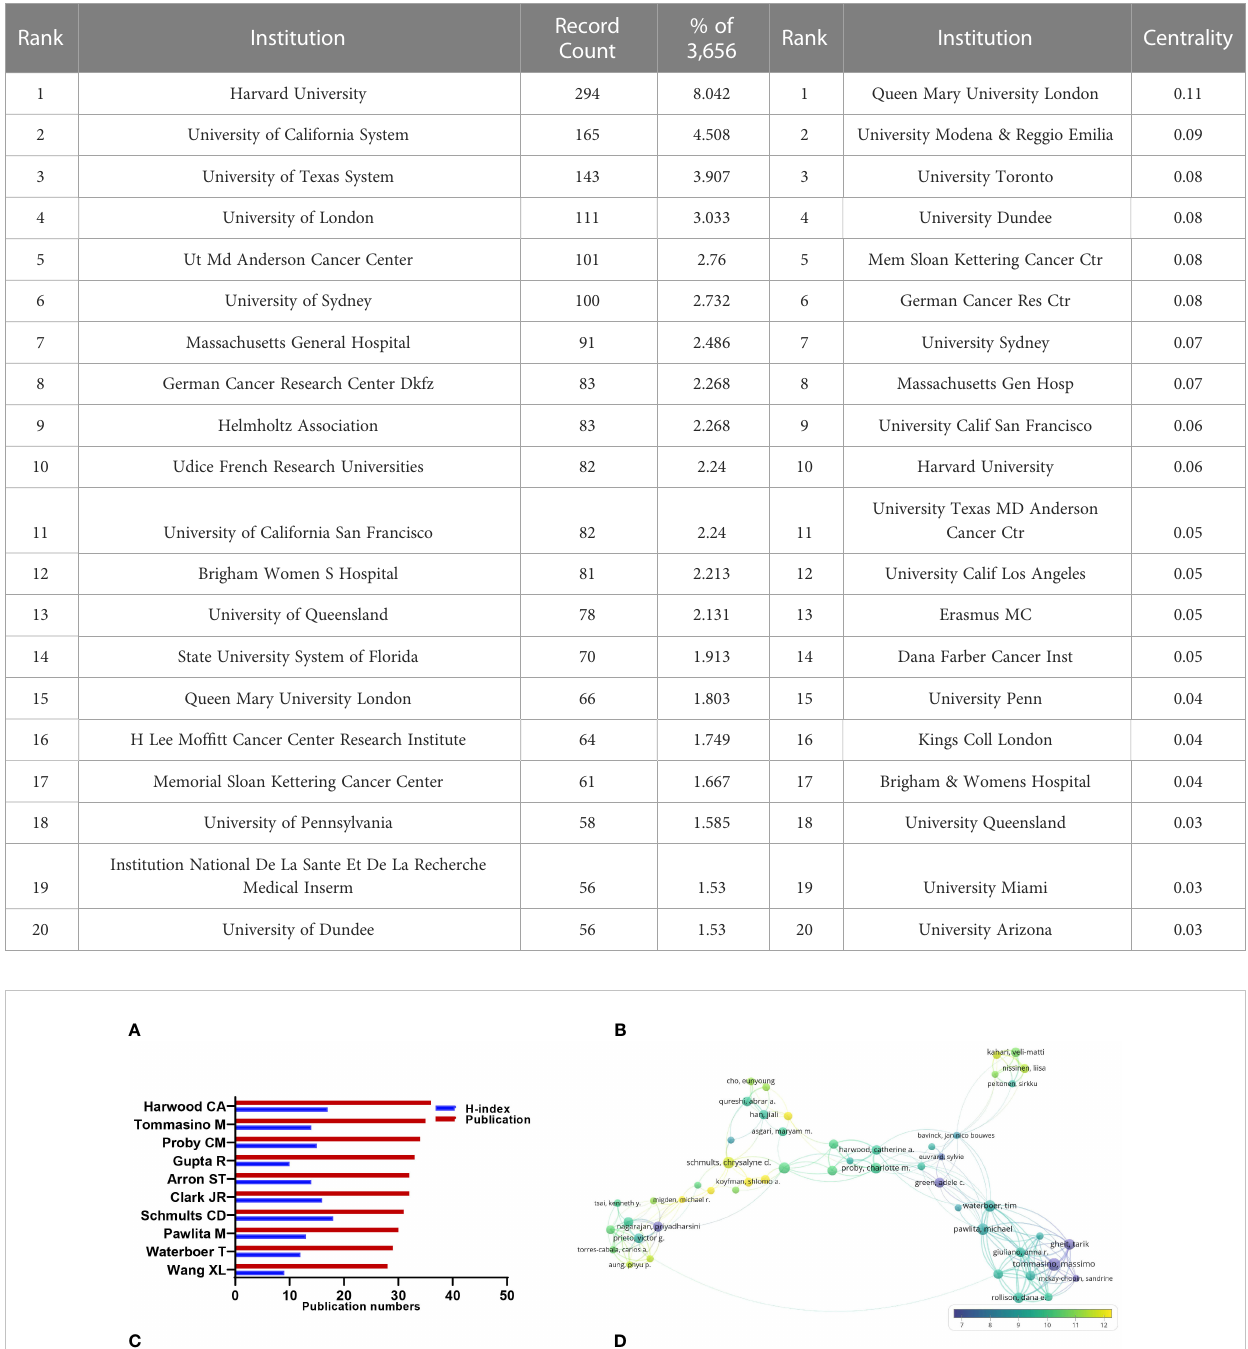
TABLE 3 Number and centrality of published literatures in different institution.